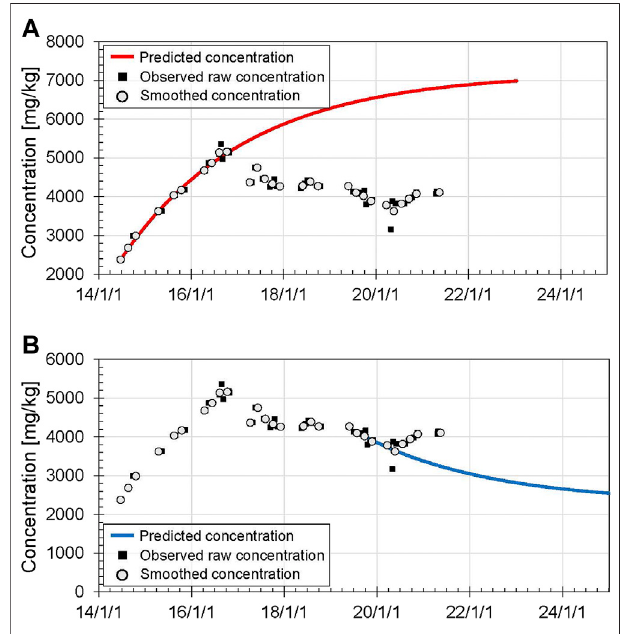
FIGURE 7 | Predicted Cl concentrations of Yugama crater lake calculatedwith Eq.5 ,assuming V and m sp donotchangeduringtheperiodof interest. Black squares and gray circles represent raw and smoothed C i values, respectively. (A) Predicted concentration curve after June 2014. The initial concentration C 0 was set to 2,380 mg/ kg. This is the smoothed Cl concentration of the lake on June 22, 2014, which was the average observed concentration over ± 60 days. C eq was set to 7,200 mg/ kg as estimated by Figure 5B . (B) Predicted concentration curve after September 2019. The initial concentration C 0 was set to 4,020 mg/kg. This is the smoothed Cl concentration of the lake on September 24, 2019, which was the average observed concentration over ± 60 days. C eq was set to 2,300 mg/ kg as estimated by Figure 5B